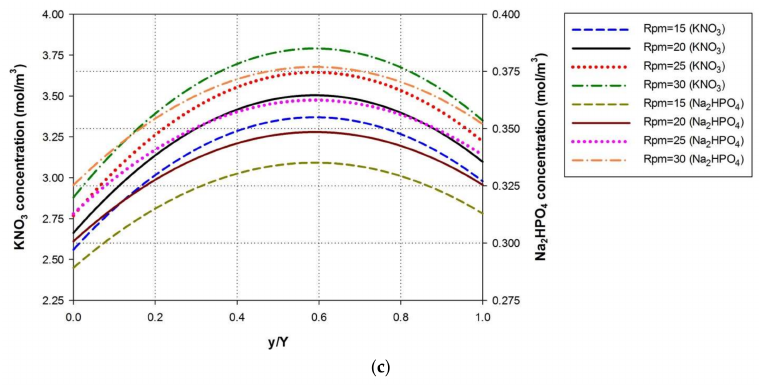
Figure 8. Effects of paddle wheel speeds on ( a ) mass transfer coefficient; ( b ) solid holdup; and ( c ) nutrient concentrations in a raceway pond with AR = 10 and water depth = 0.2